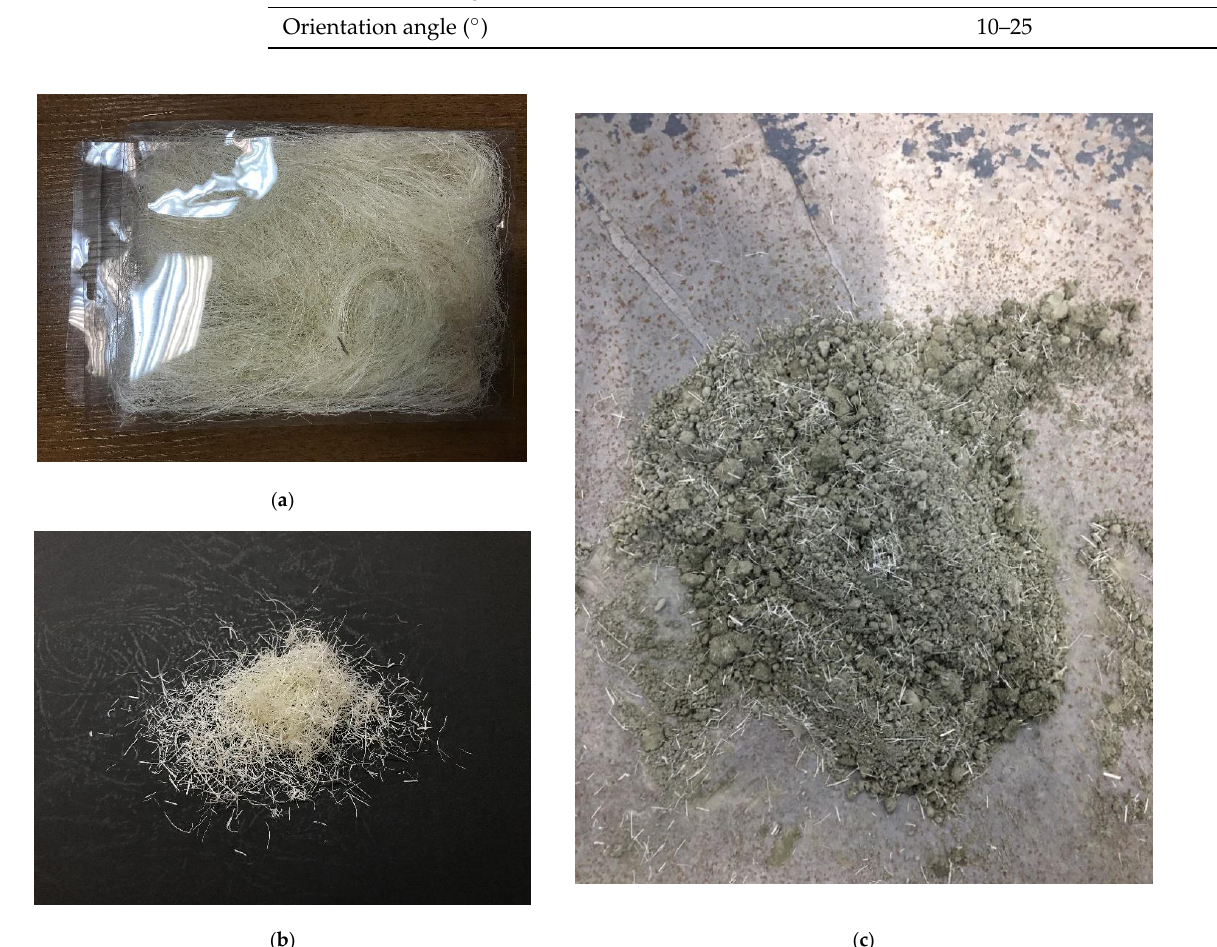
Figure 2. Appearance of the sisal fiber used: ( a ) in the package; ( b ) after cutting; ( c ) dry mix.